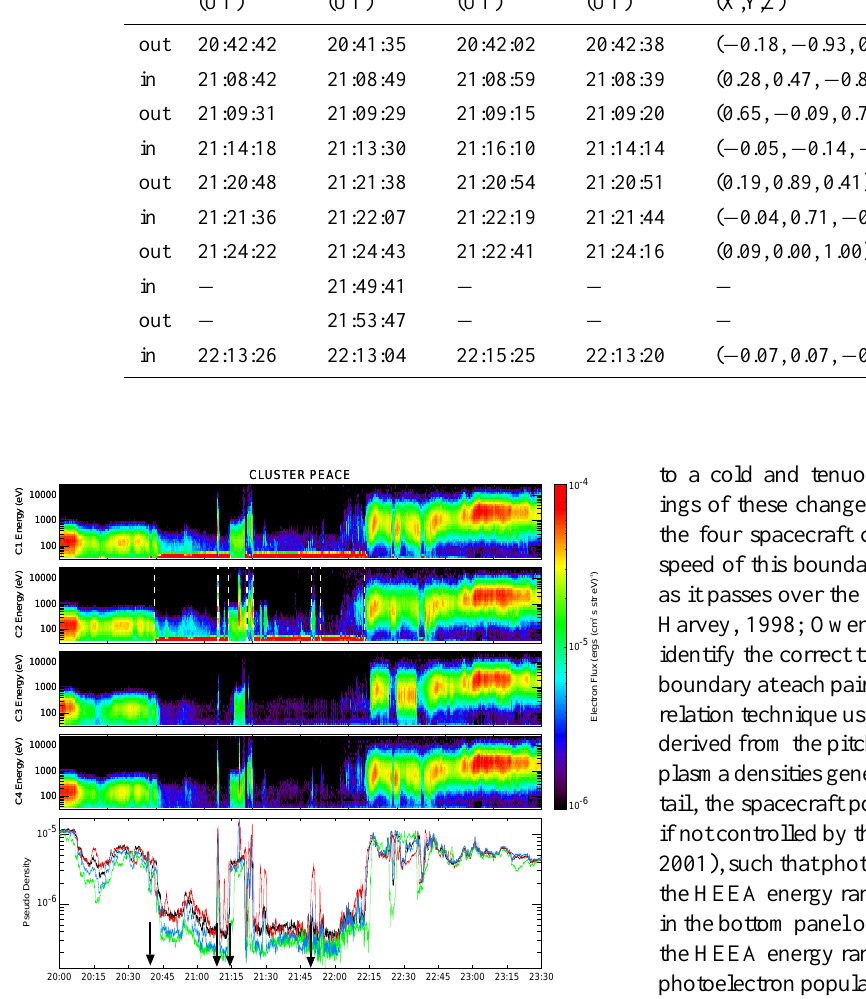
Fig. 15. Electron energy spectrograms, measured by PEACE on all four s/c and (bottom) the partial electron density (for the exact def- inition see text). Vertical dashed lines in the second panel mark the plasma sheet boundary crossing times (cf. Table 1). The substorm onset and intensification times as determined from the ground-based magnetic field data are marked with the black arrows in the bottom